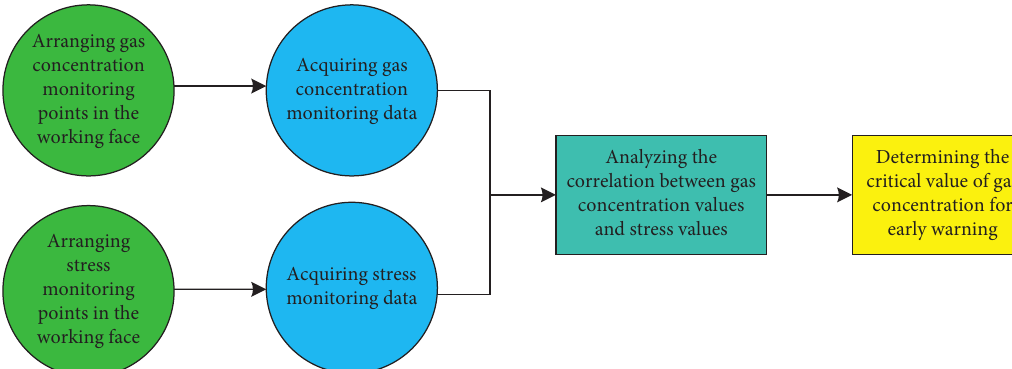
Figure 5: Flowchart of early warning method of rock burst in the deep mine working face based on the law of gas emission.